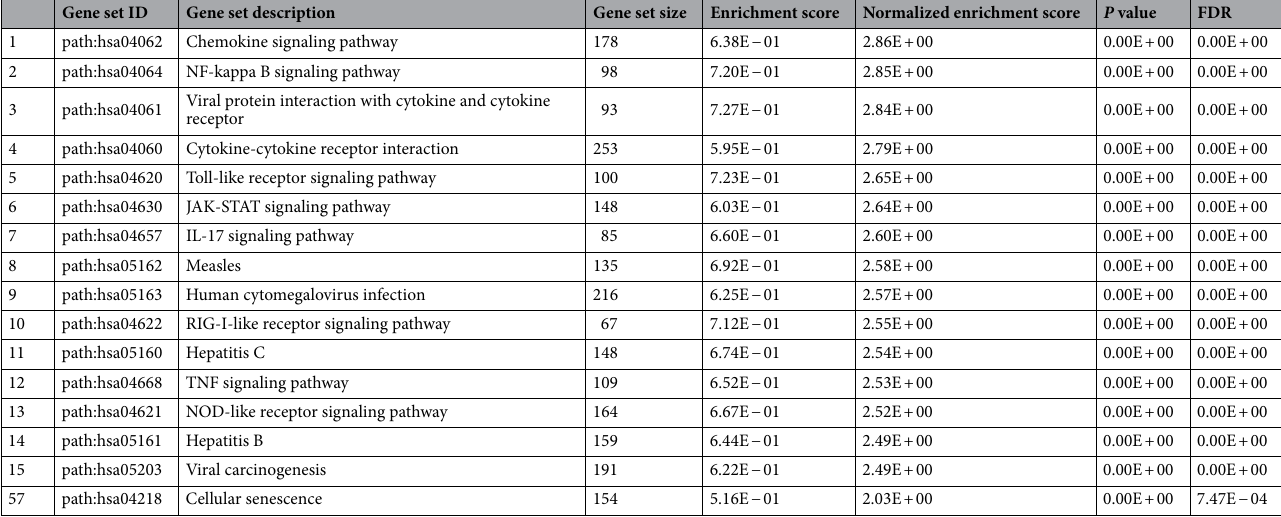
Table 1. KEGG pathway analysis of BALF cells derived from COVID-19 patients compared to those from healthy controls. Ranked in order of normalized enrichment score